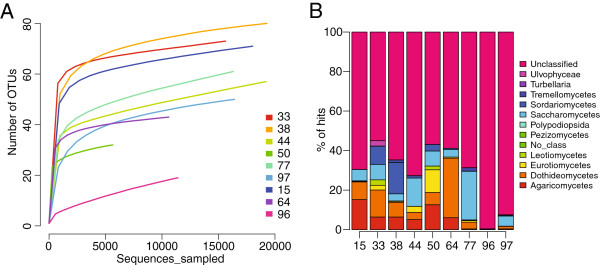
CloVR-ITS rarefaction and histogram visualizations for gastric fluid data. Example outputs of the CloVR-ITS pipeline for the human gastric fluid data: (A) rarefaction curves of genus-level OTUs (85% identity threshold for clustering) and (B) stacked histograms displaying relative abundances at the taxonomic class level (60% identity threshold over 90% of the sequence).